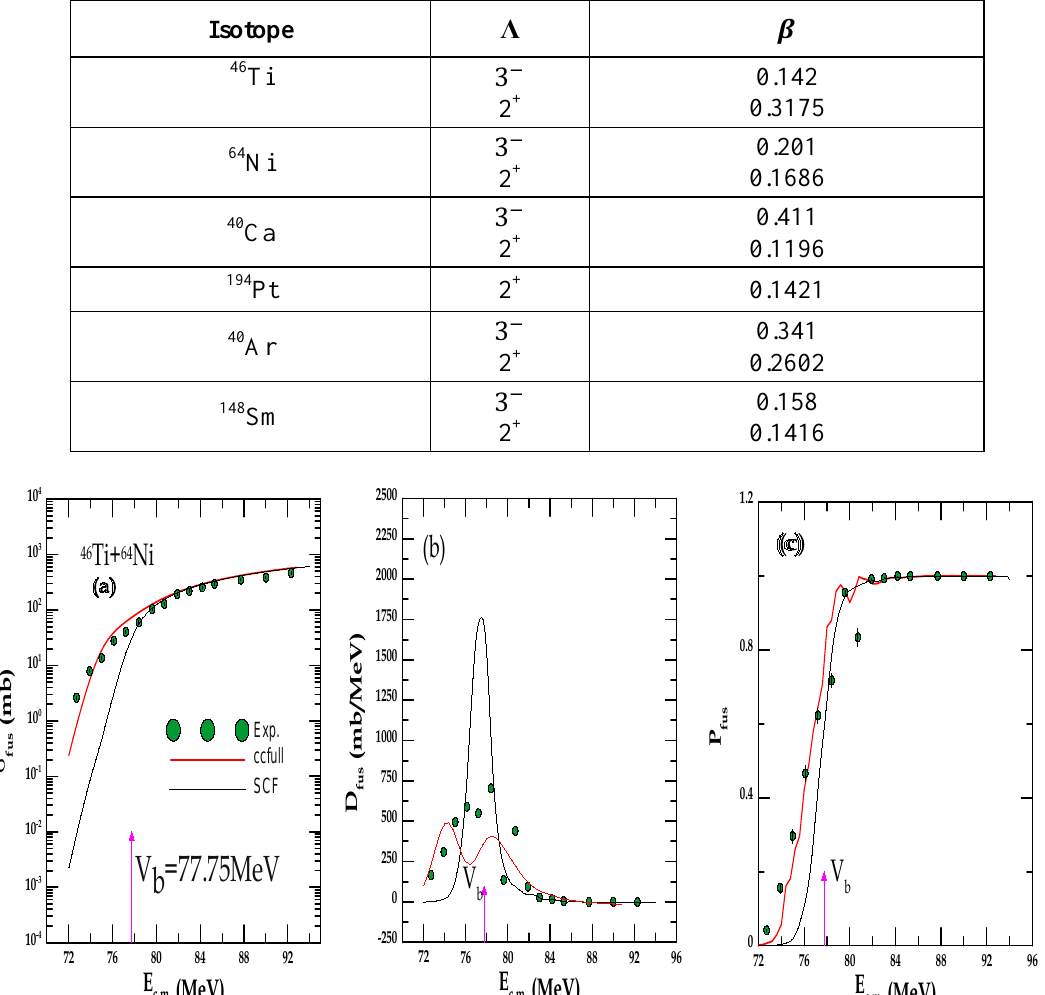
Table: 2 The deformation parameters [18, 19].